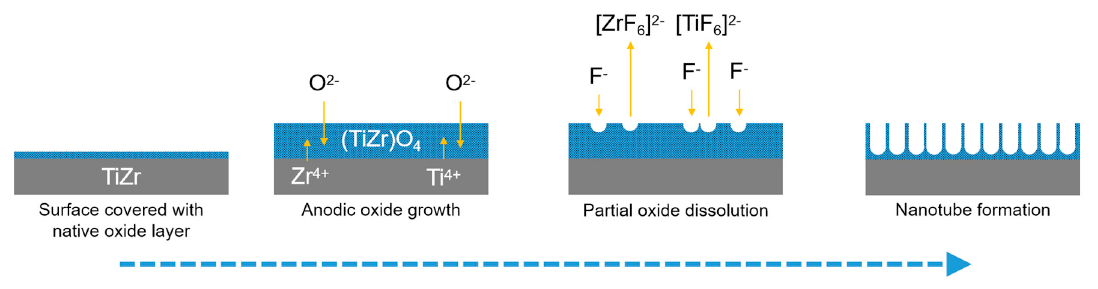
Figure 3. Schematic representation of the process for obtaining ordered TiZr oxide nanostructures.